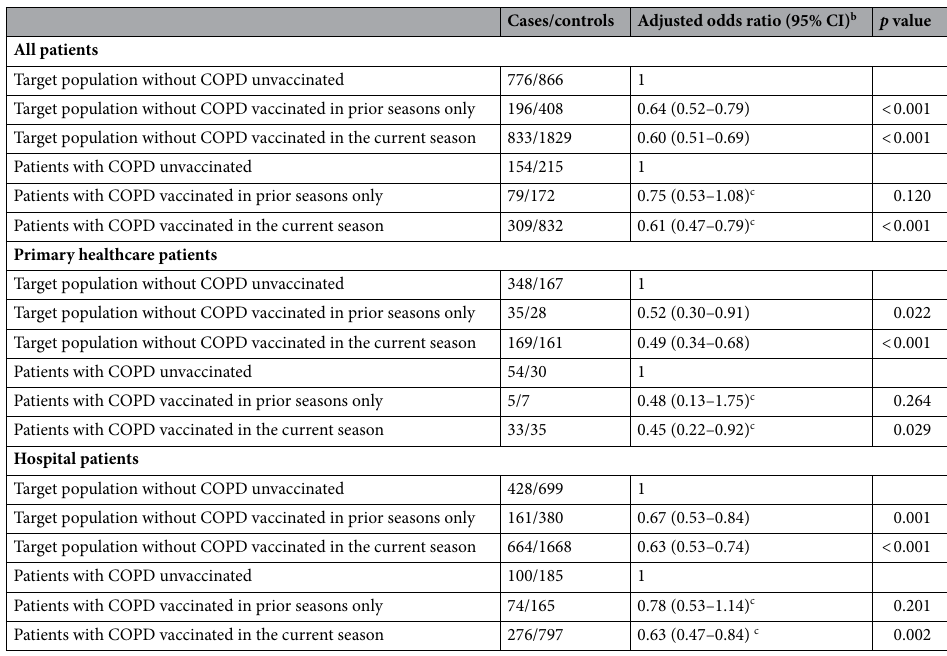
Table 4. Effect of influenza vaccination status in the current and 5 prior seasons in preventing laboratory- confirmed influenza in the target population for influenza vaccination a with and without chronic obstructive pulmonary disease. CI confidence interval, COPD chronic obstructive pulmonary disease. a Target population for influenza vaccination included people ≥ 60 years or with major chronic conditions. b Odds ratio adjusted by age groups (25–64, 65–84 and ≥ 85 years), other major chronic conditions, healthcare setting (primary healthcare or hospital), and month-season of sample collection. c Comparison of the adjusted odds ratios in COPD vs. non-COPD patients: all patients with current season vaccination, p = 0.339; all patients with vaccination in prior seasons only, p = 0.712; outpatients with current season vaccination, p = 0.468; outpatients with vaccination in prior seasons only, p = 0.745; inpatients with current season vaccination, p = 0.345; inpatients with vaccination in prior seasons only, p = 0.701.